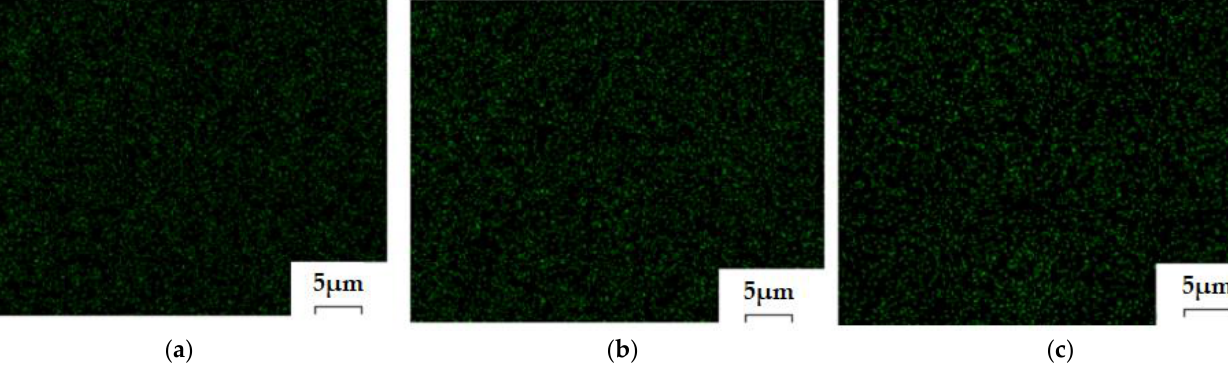
Figure 15. Osmium distribution images by energy-dispersive spectroscopy analysis (EDAX) for the osmium – polymer- obtained membranes: Os – CA membrane ( a ); Os – PSf membrane ( b ); OS – PP membrane ( c ). Table 2. Energy-dispersive spectroscopy analysis (EDAX) for the osmium – polymer membranes.